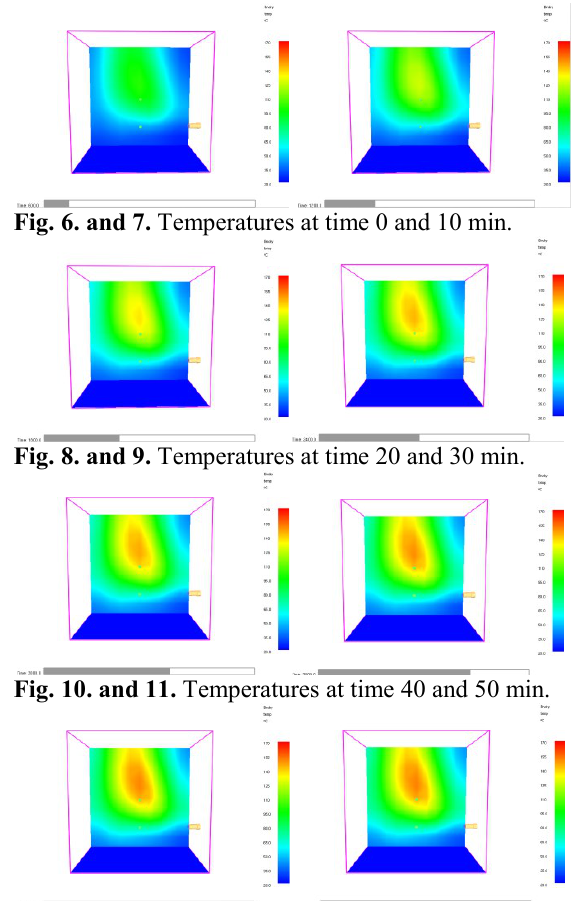
Fig. 12. and 13. Temperatures at time 60 and 70